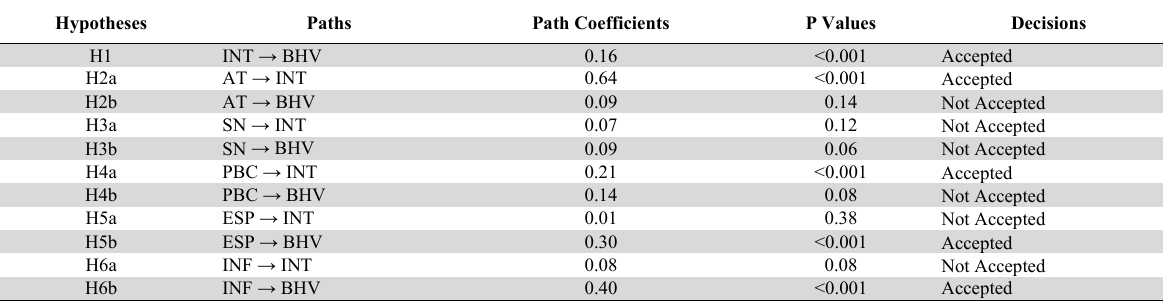
Results of Path